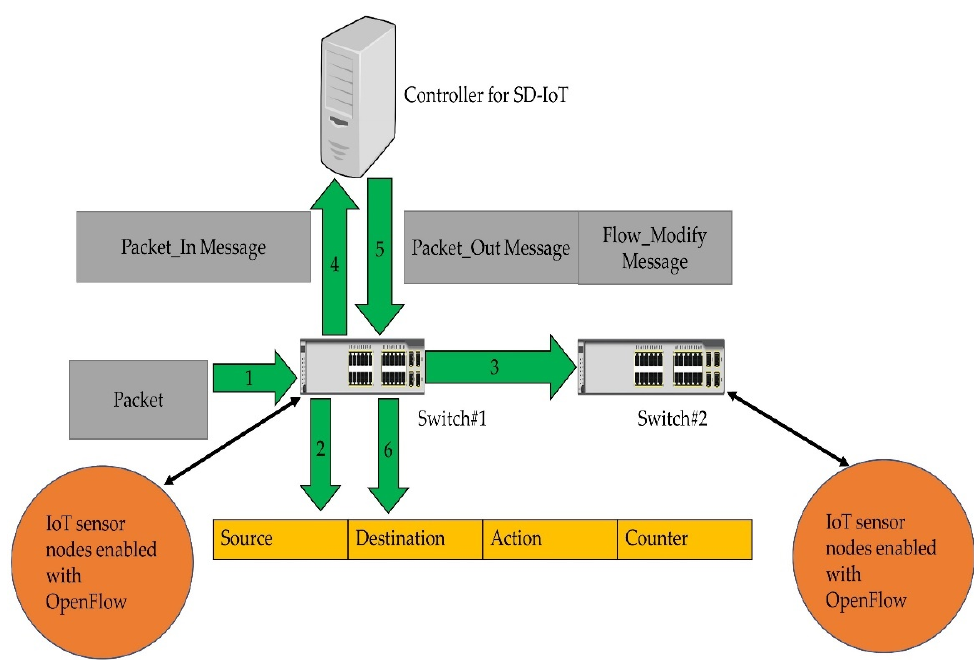
Figure 1. Packet processing in SD-IoT.